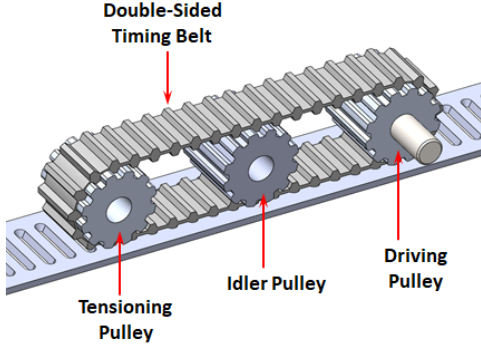
Figure 1. Schematic of the B-SALD functioning